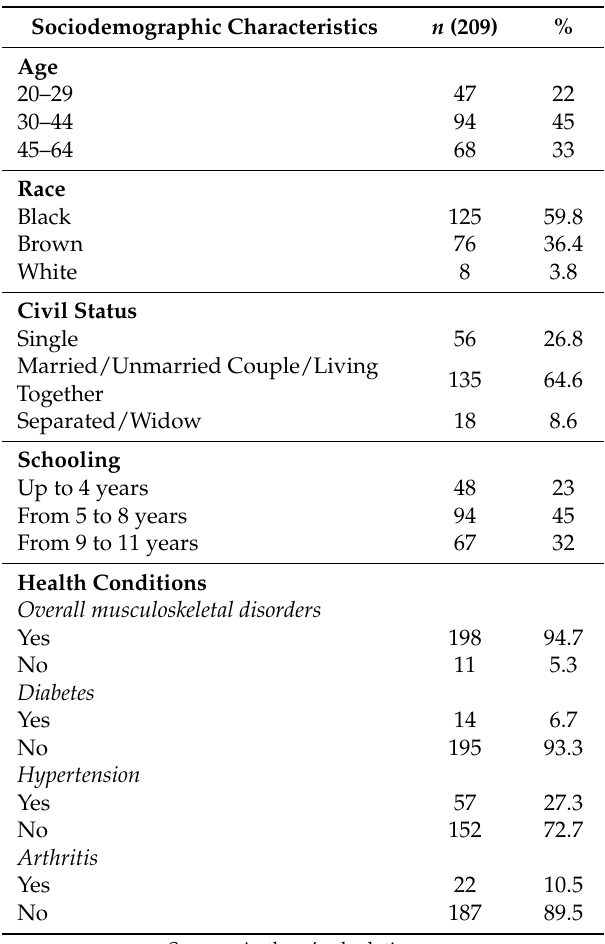
Table 2. Sociodemographic characteristics and the health conditions of artisanal fisherwomen/shellfish gatherers from the municipality of Saubara-Bahia, Brazil, 2013 ( n =